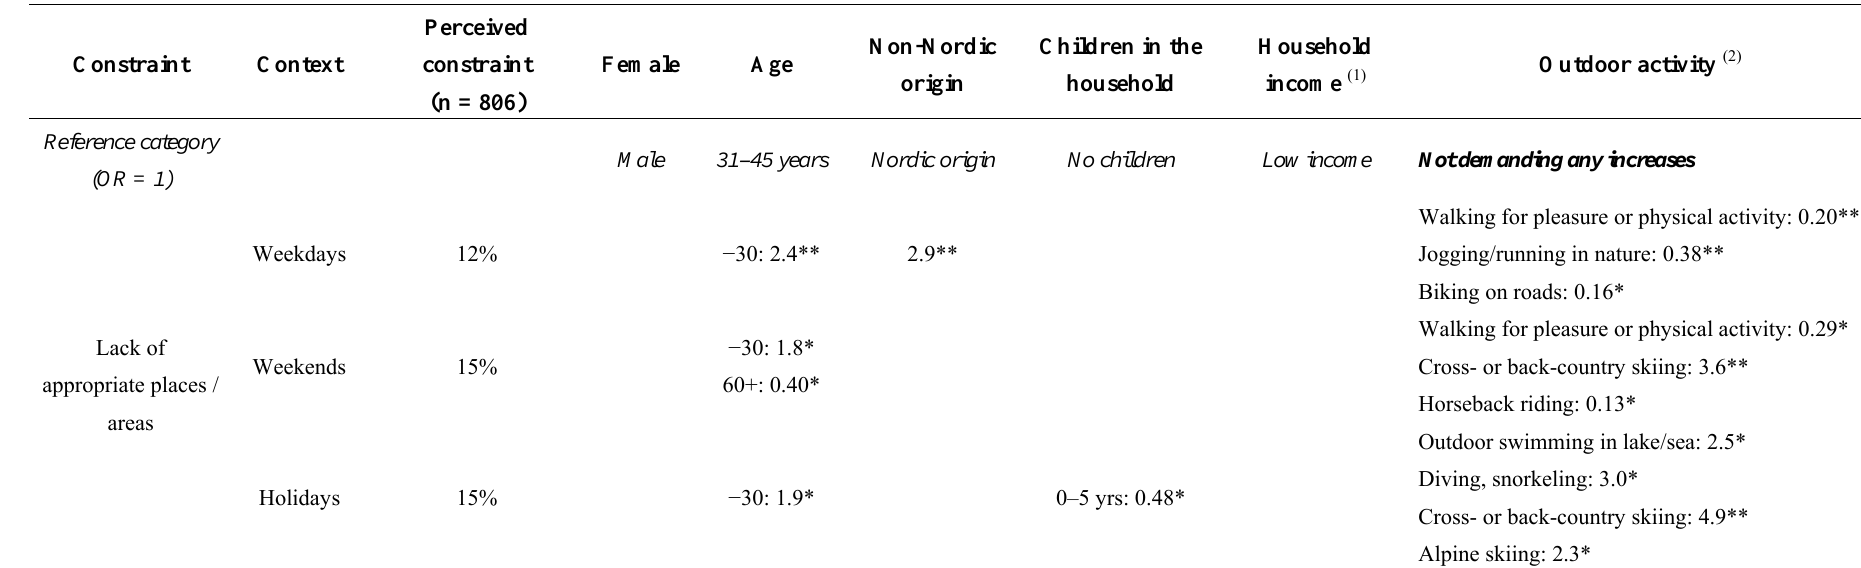
Table 3. Logistic regression analyses of constraints to increase participation in outdoor recreation activities. Significant (p < 0.05) odds ratios (OR) are shown in the